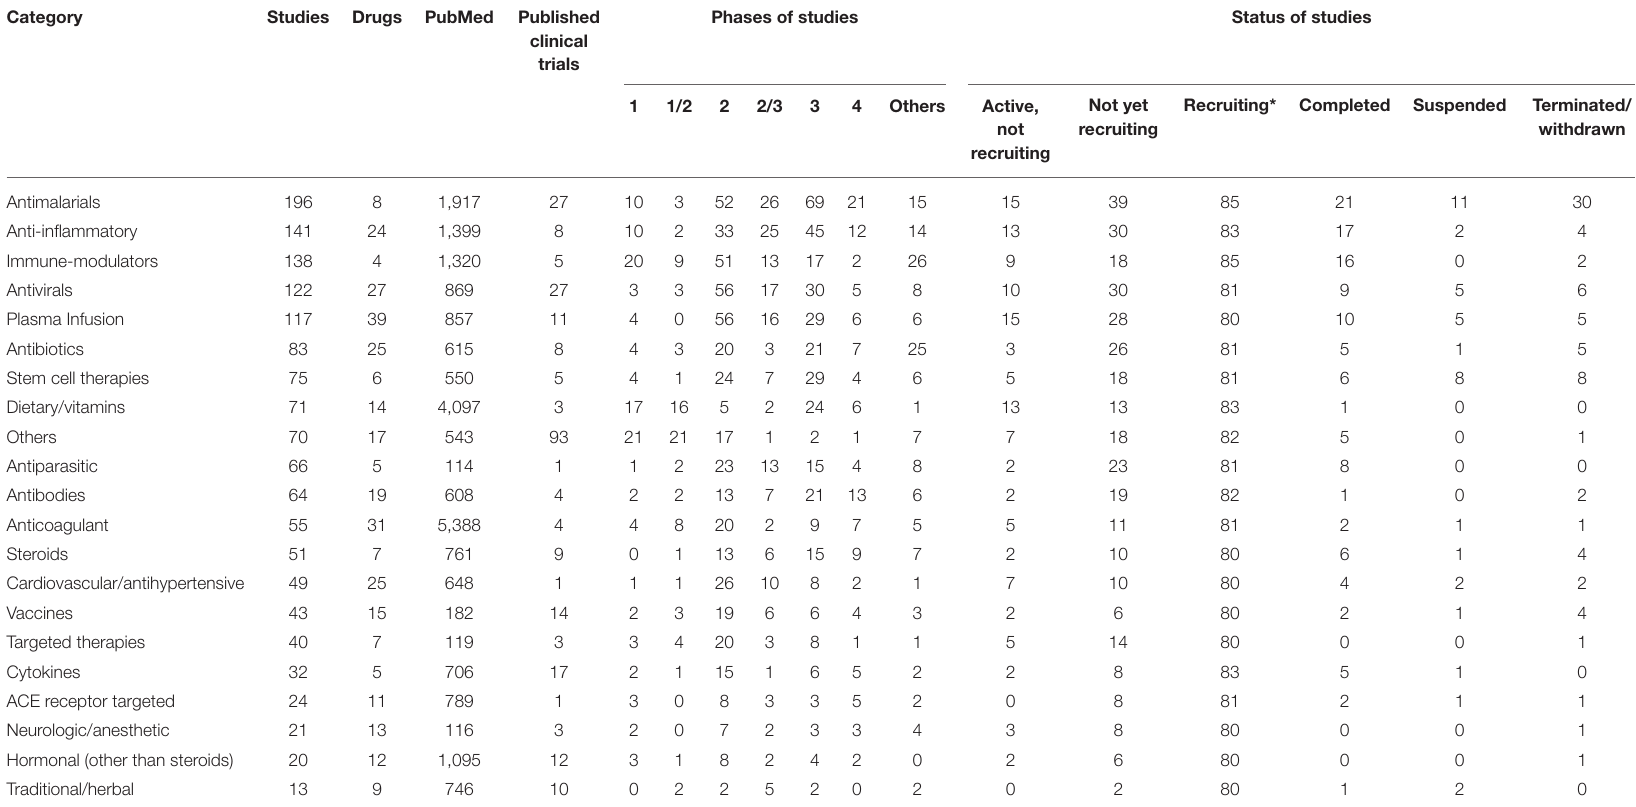
TABLE 1 | Categories of drugs under Investigation for COVID19 Treatment or Prevention (2,145 interventional studies registered on ClinicalTrials.gov as of October 31, 2020).